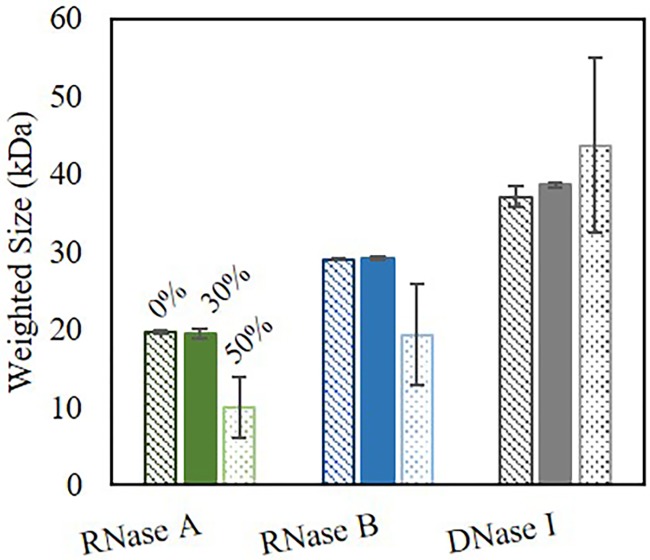
Weighted size (kDa) of RNase A, RNase B, and DNase I.Weighted size post microwave irradiation of 30% and 50% power, 60 seconds as compared to pre (0%). In general, as microwave power increases, the overall weighted nuclease size decreases and the error in the size becomes larger. This in indicative of an increasing number of varying size fragments with an overall degraded nuclease.